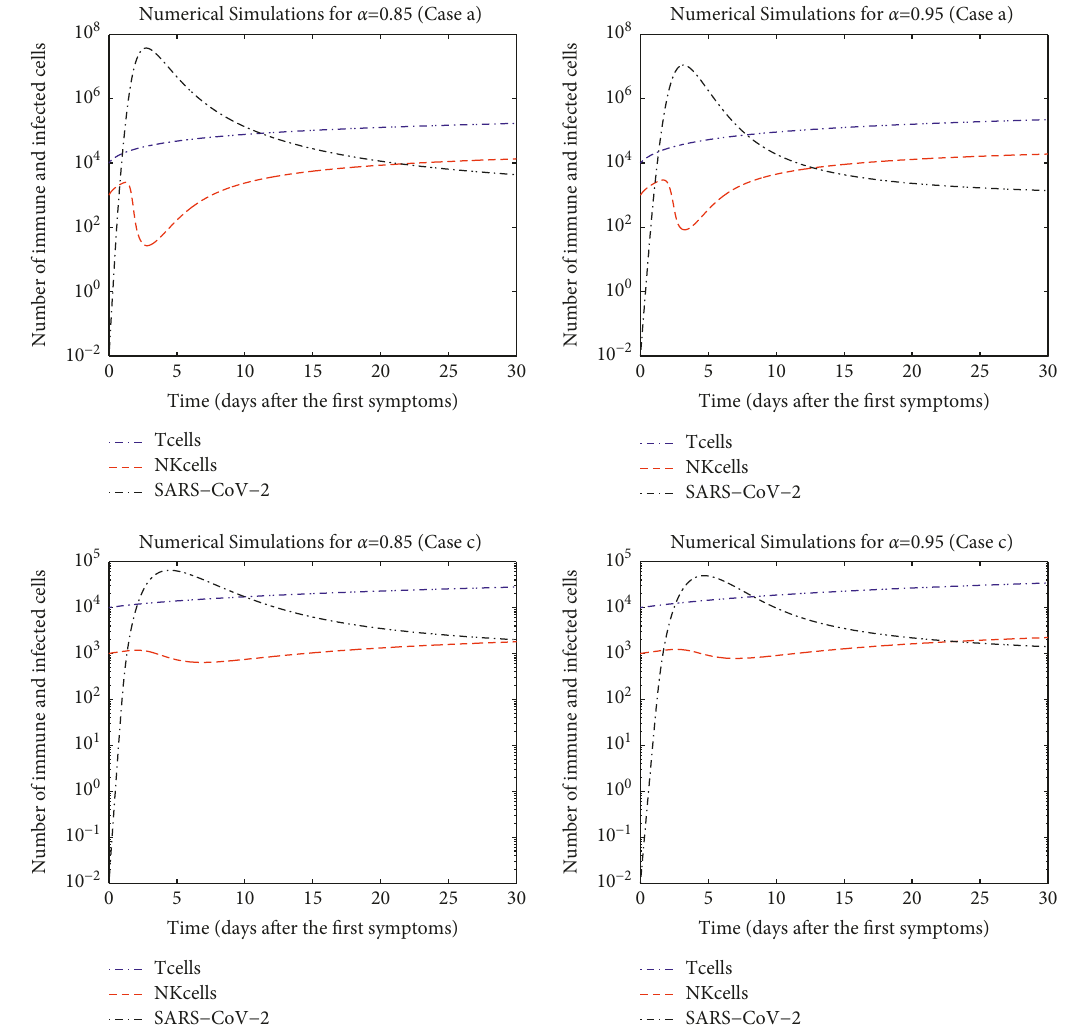
Figure 8: Numerical solutions of the model (1) for patient a , c .